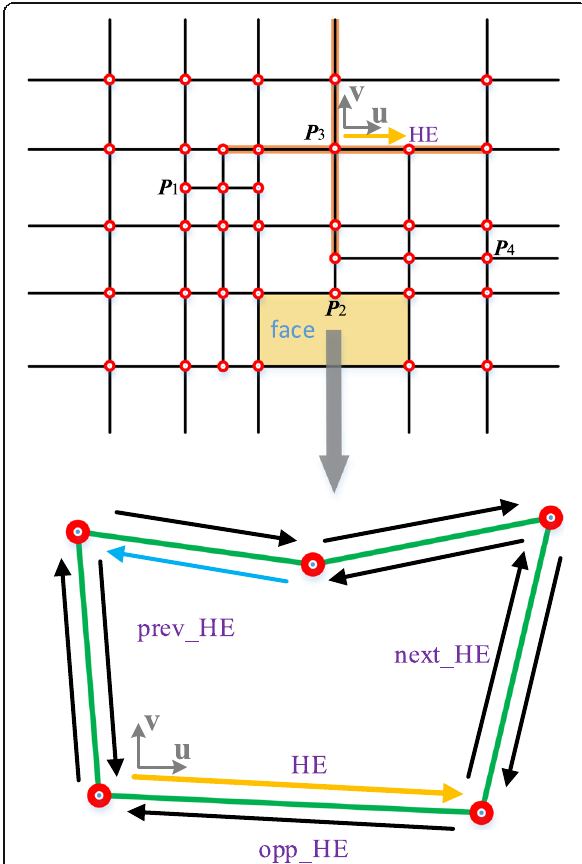
Fig. 6 Schematic of the proposed data